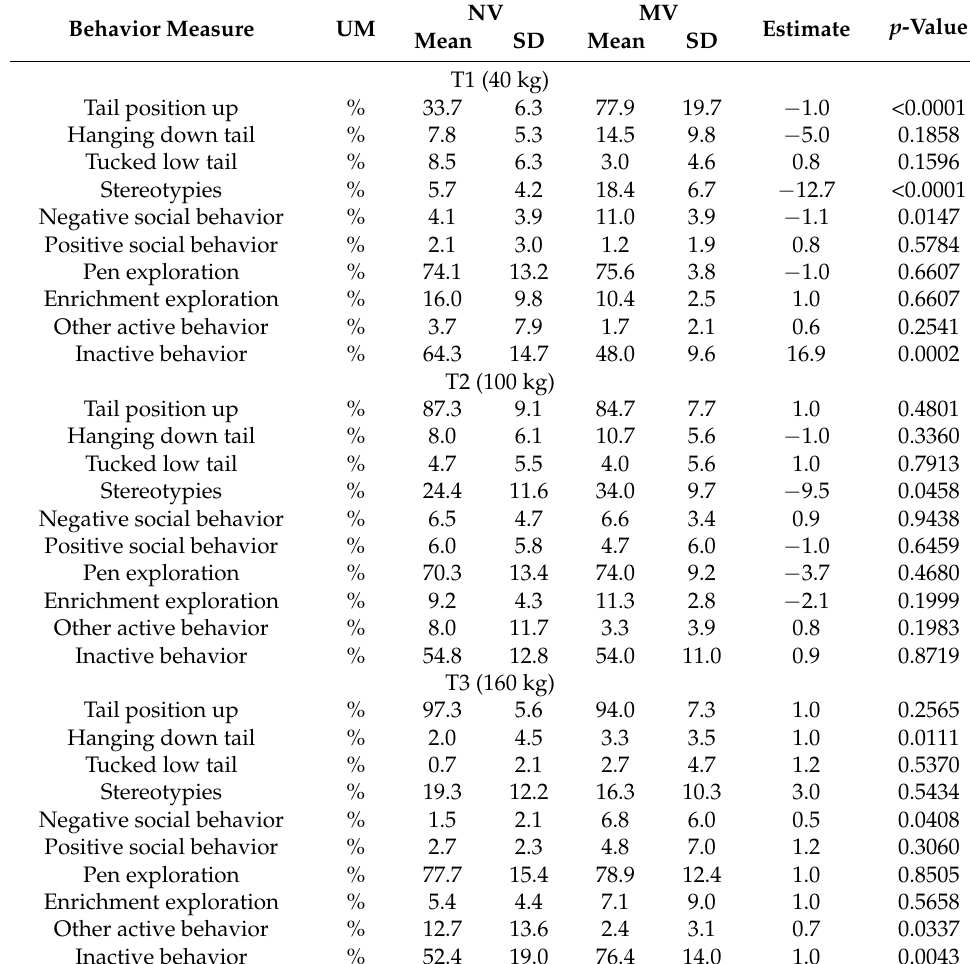
Table 4. Behaviors observed in the study in the two